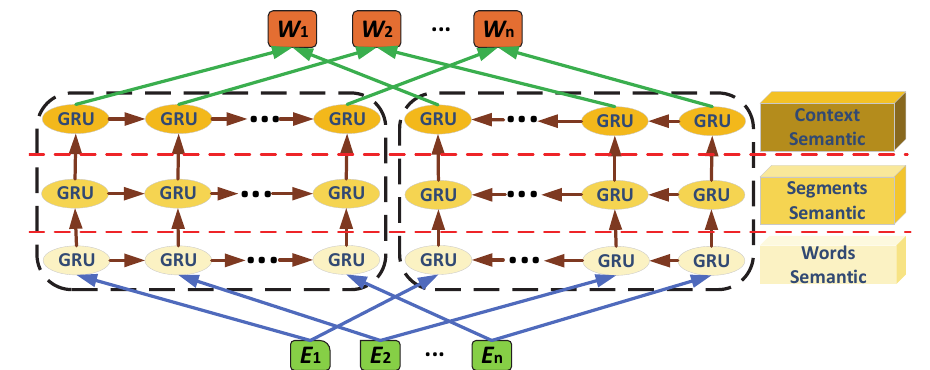
Figure 2. Context Semantic Encoding Structure of the 3EAG Model.